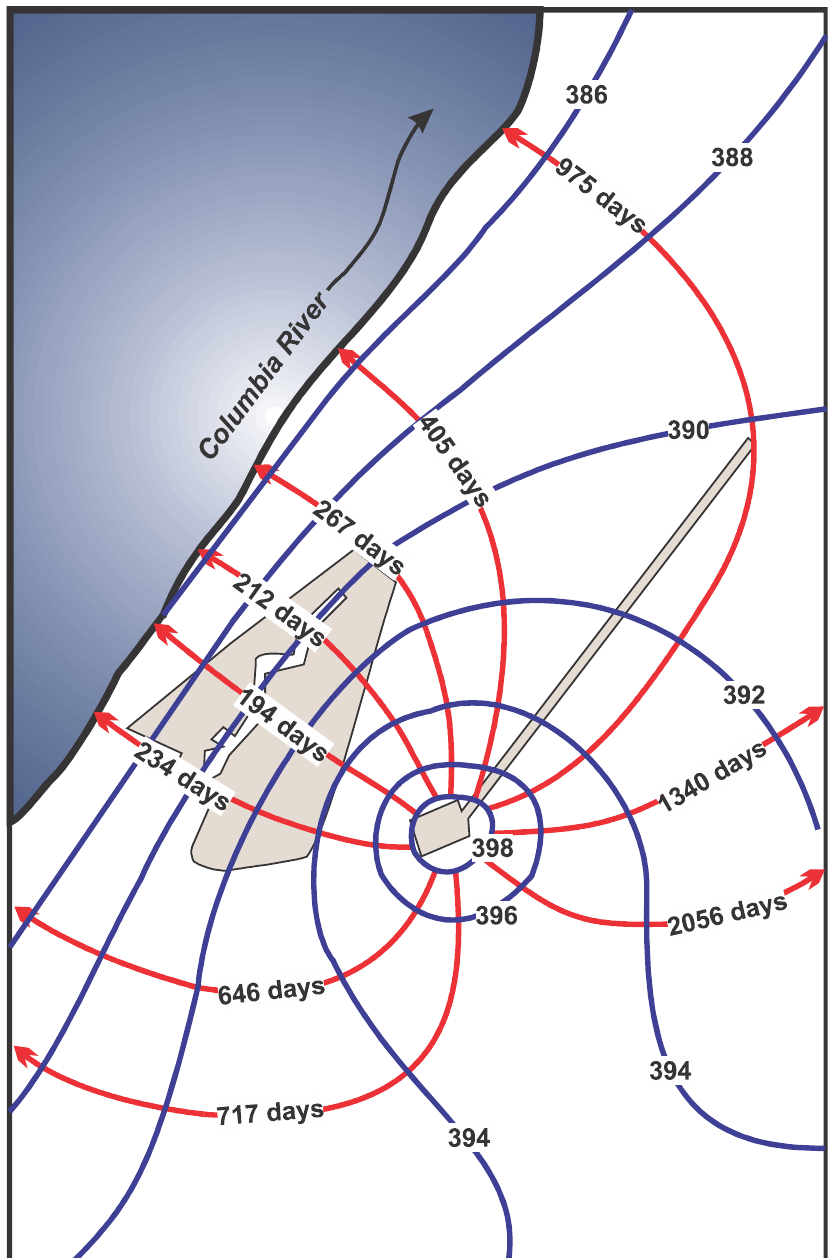
Figure 2. Steady state results from the VTT model (heterogeneous system) providing best estimates of travel times from the 1325 crib to the river. This represents the heterogeneous system we bounded with the homogenous PATHS model. the homogenous PATHS